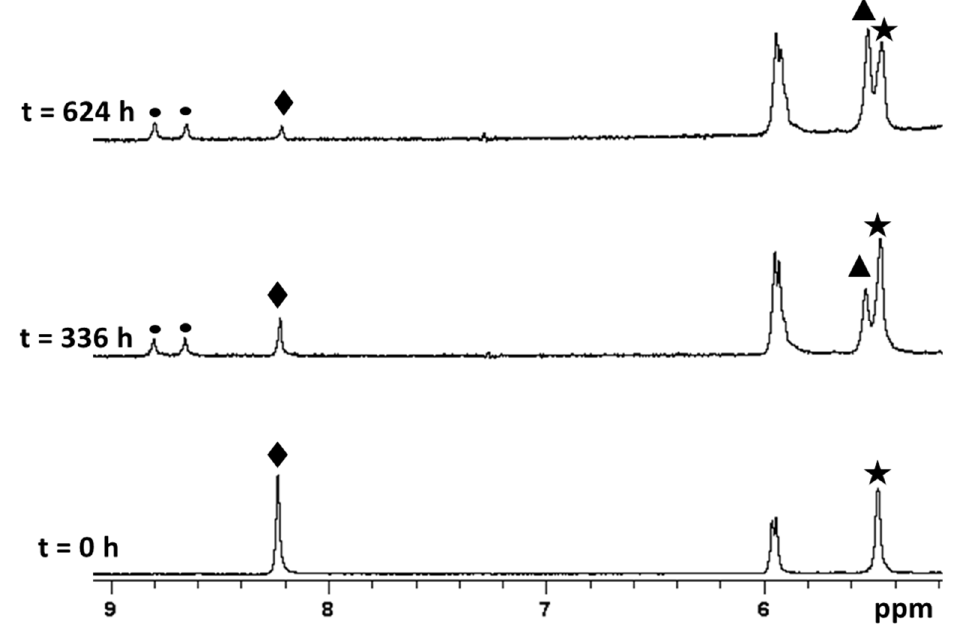
Figure 10. 1 H NMR spectra at different times of 2 (5 mM) in the presence of 5’-GMP (12.5 mM) at pH* = 7.4 (D 2 O, 50 mM